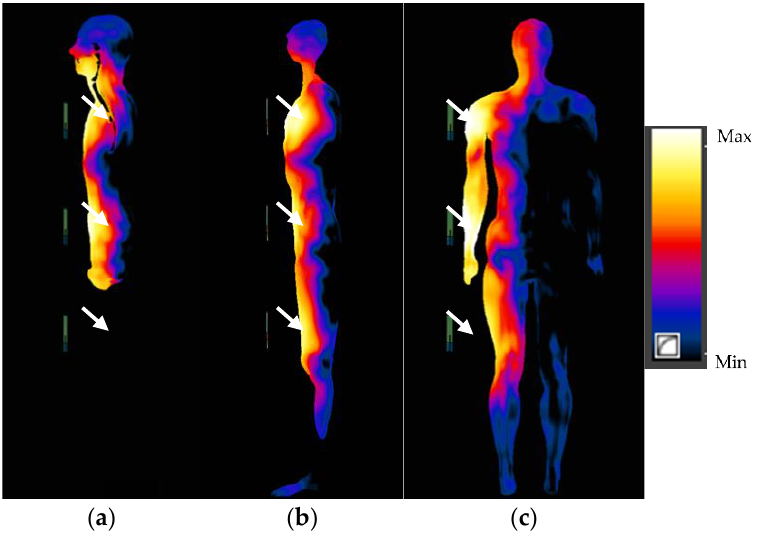
Figure 5. SAR distributions in the human body exposed to EMF near a UHF I-RFID three-antenna reader located 5 cm from the body: ( a , b ) in the body’s sagittal cross-sections through the body’s main axis and 6 cm to side (through the leg) in scenario PF and ( c ) in the body’s frontal cross-section in scenario PS; antennas marked with white arrows.